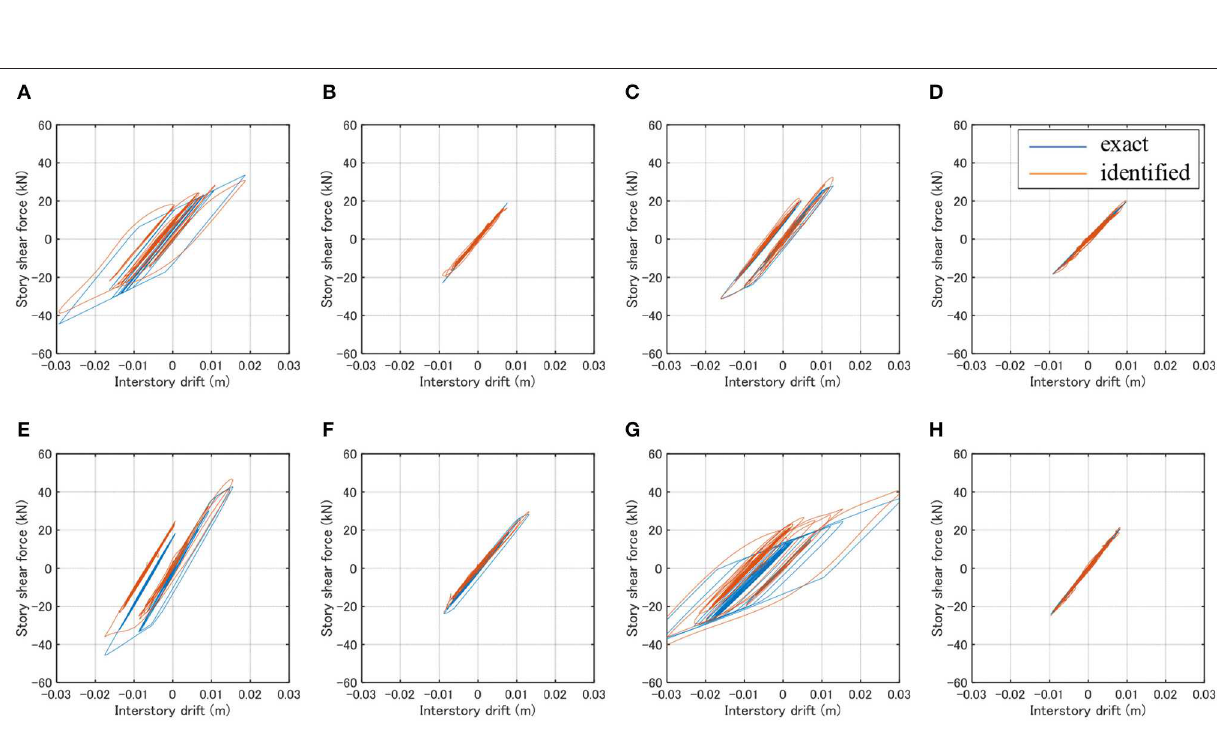
Frontiers in Built Environment |